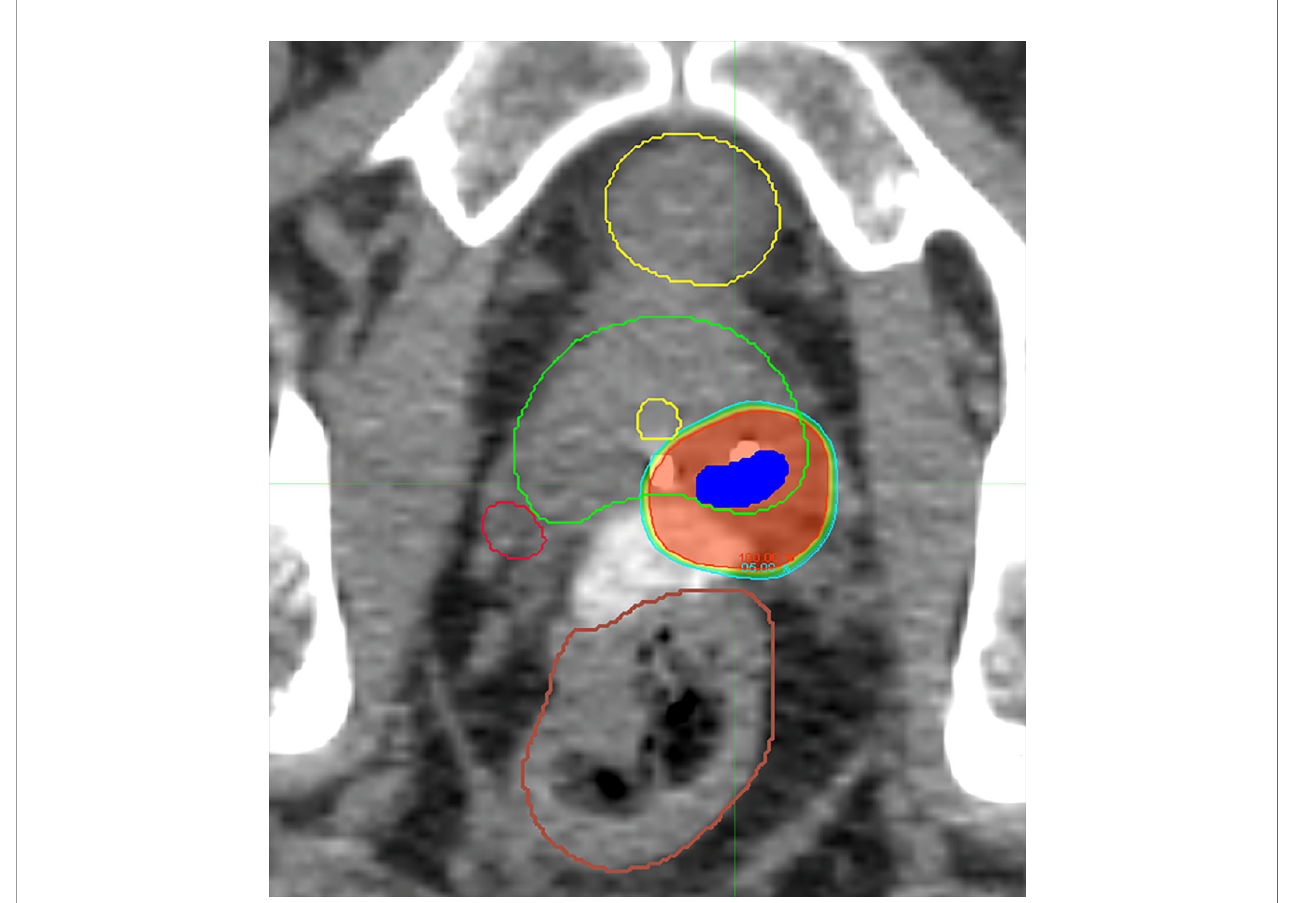
FIGURE 2 | Representative axial CT slice with isodose lines from a delivered f-SBRT plan demonstrating sparing of the uninvolved prostate gland, bladder, rectum, urethra, and contralateral neurovascular